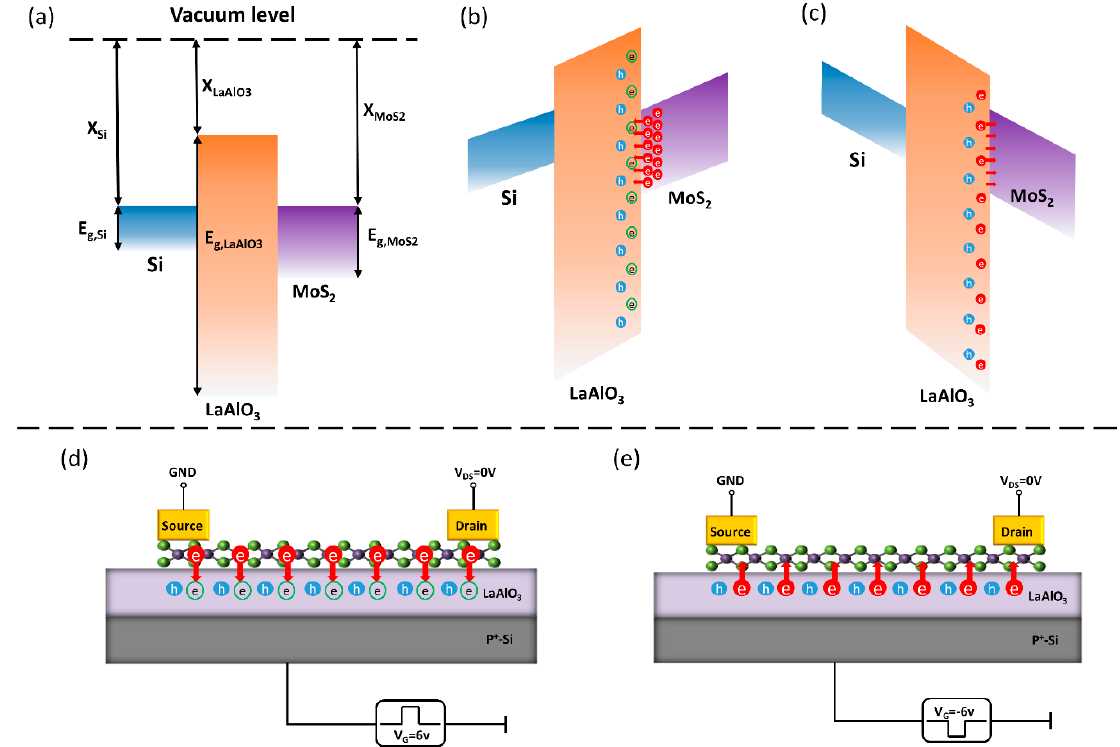
Figure 5. ( a ) The energy band diagram without the applied voltage (X Si ≈ 4.13 eV, E g,Si ≈ 4.13 eV, X LaAlO3